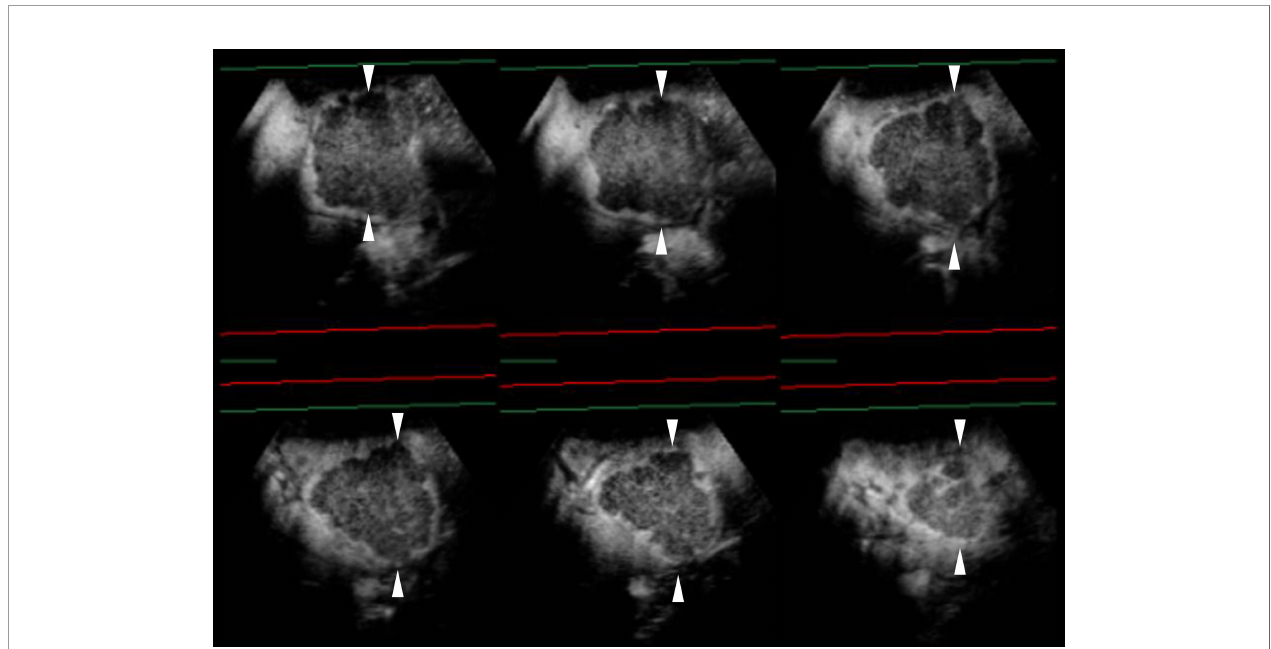
FIGURE 3 | Sonazoid-enhanced ultrasound (US) images of a man in his seventies with a pathological diagnosis of moderately differentiated hepatocellular carcinoma (HCC), who had a history of hepatitis C. The tumor was 70mm. Consecutive lateral images of the tumor remarkably illumed the irregular margin on the three-dimensional (3D) US, which was obtained by auto-sweep 3D scanning in the post-vascular phase. Tomographic ultrasound images in plane A, which can be translated from front to rear, with a slice distance of 4.8 mm. Arrowheads indicate the margin of the HCC